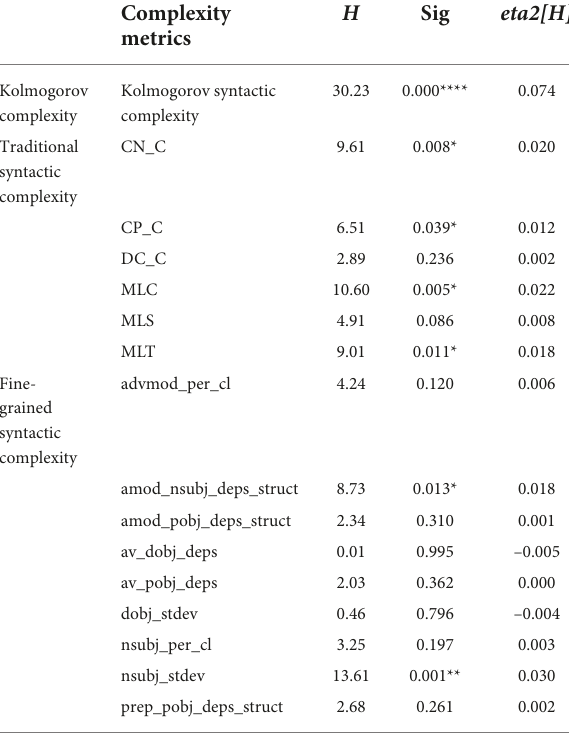
TABLE 4 Differences in syntactic complexity metrics among A2_0, B1_1, and